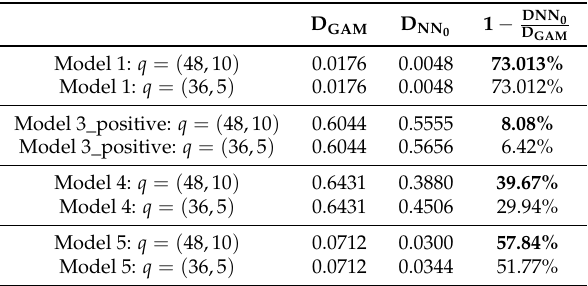
Table 5. Minimal cross-entropy and deviance loss functions on validation sets observed during the training of the neural networks in k = 17.